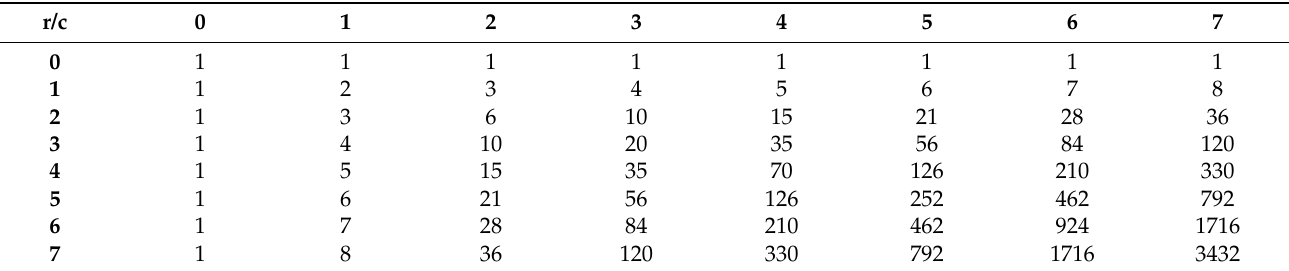
Table 1. Pascal’s triangle values (adapted from